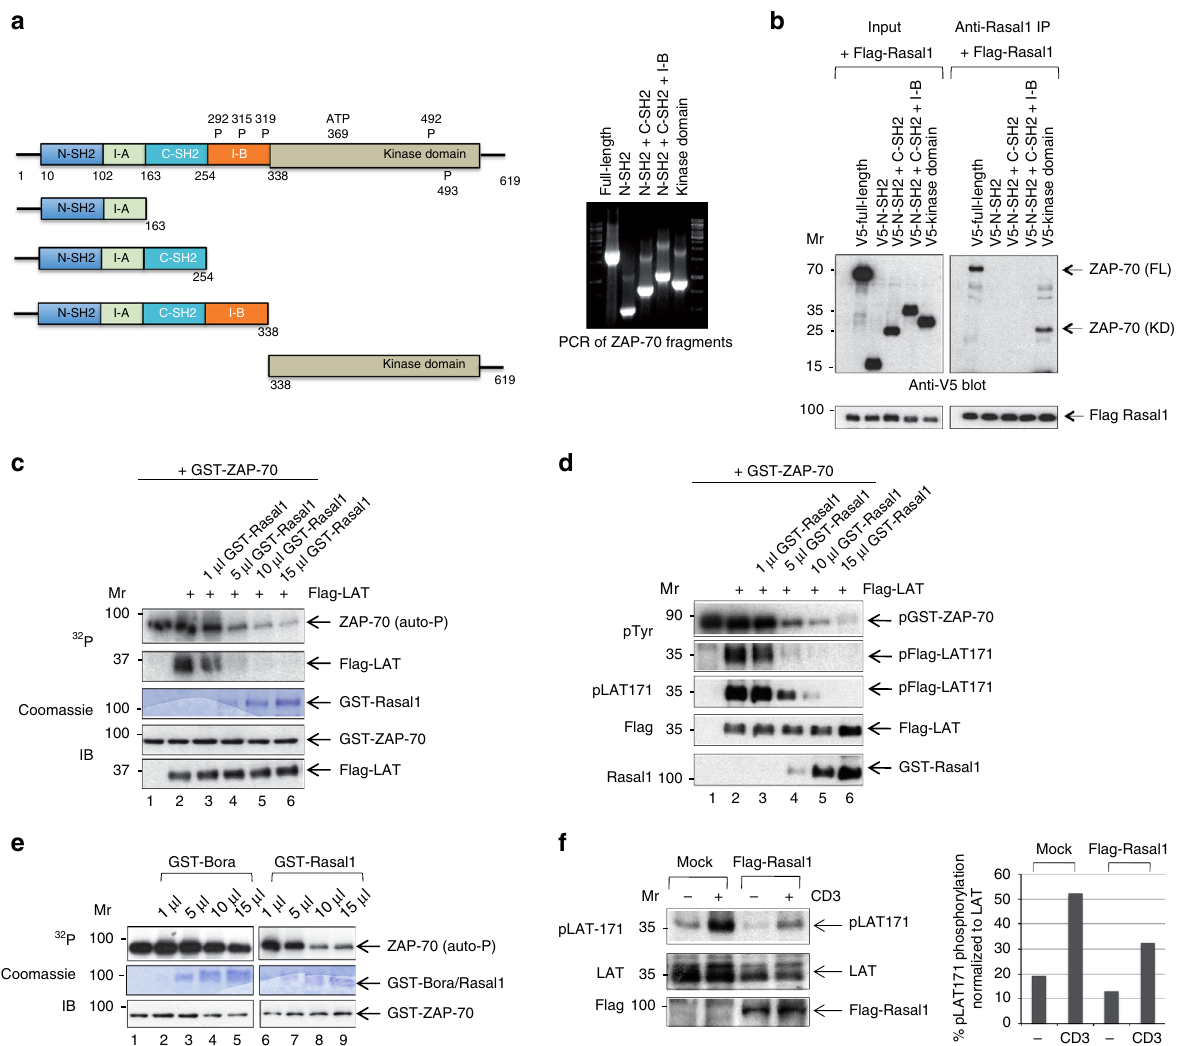
Fig. 3 Rasal1 binds to the kinase domain of ZAP-70 and inhibits ZAP-70 kinase activity. a Deletion mutants of ZAP-70 that include the V5-tagged N- terminal SH2 domain plus the intervening region, the N-terminal SH2 domain plus the intervening region and the C-terminal-oriented SH2 domain, the N- terminal SH2 domain plus the intervening region and the C-terminal-oriented SH2 domain plus the intervening I-B region and the kinase domain of ZAP-70. Right panel: PCR of ZAP-70 fragments. b The Rasal1 binds to the kinase domain of ZAP-70. Each of the proteins were expressed in 293T cells in the presence of Flag-tagged Rasal1 (left panel ) . Anti-Rasal1 precipitation resulted in the co-precipitation of full-length ZAP-70 and the kinase domain of ZAP- 70 (right panel) ( n = 2). c Rasal1 inhibits the kinase activity of ZAP-70 and the phosphorylation of LAT. Recombinant active ZAP-70 from baculovirus was incubated with Flag-LAT from 293T cells as a substrate in the presence of increasing concentrations of GST-Rasal1 and γ -32P ATP for 30 min at 37 °C. Increasing concentrations of GST-Rasal1 inhibited ZAP-70 autophosphorylation and the phosphorylation of LAT (lanes 3 – 6). Lower panels: input levels of GST-ZAP-70 and LAT were assessed by western blotting ( n = 2). d Rasal1 inhibits the kinase activity of ZAP-70 and the phosphorylation of LAT. Recombinant active ZAP-70 from baculovirus was incubated with Flag-LAT from 293T cells as a substrate in the presence of increasing concentrations of GST-Rasal1 and cold ATP for 30 min at 37 °C. Increasing concentrations of GST-Rasal1 inhibited ZAP-70 autophosphorylation and the phosphorylation of LAT ( n = 2). Lower panels show blots for Flag-LAT and GST-Rasal1 expression. e Rasal1, but not Bora, inhibits the kinase activity of ZAP-70 and the phosphorylation of LAT. Recombinant active ZAP-70 from baculovirus was incubated with GST-Bora or GST-Rasal1 with γ -32P ATP for 30 min at 37 °C. Increasing concentrations of GST-Rasal1, but not GST-Bora, inhibited ZAP-70 autophosphorylation. GST-Bora (lanes 2 – 5); GST-Rasal1 (lanes 6 – 9). f LAT phosphorylation of Y-171 is reduced in the presence of Rasal1 in Jurkat T-cells. Jurkat cells were transfected with Rasal1 and ligated for 5 min with anti-CD3. Rasal1 transfection (lanes 3, 4); resting (anti-IgG) (lanes 1, 3); anti-CD3 (lanes 3, 4) ( n = 3). Right panel: histogram showing the quanti fi cation of phospho- LAT normalized to total LAT levels in the mutants of ZAP-70 were cloned and expressed for binding studies (Fig. 3a). These deletion mutants included the N-SH2 domain with the intervening I-A region, the N- and C-SH2 domains with the intervening I-A region, the N- and C-SH2 domains with the intervening I-A and I-B region, and the isolated kinase domain (left panel). The PCR products for the ZAP-70 fragments are also shown (right panel). Each protein was then expressed in